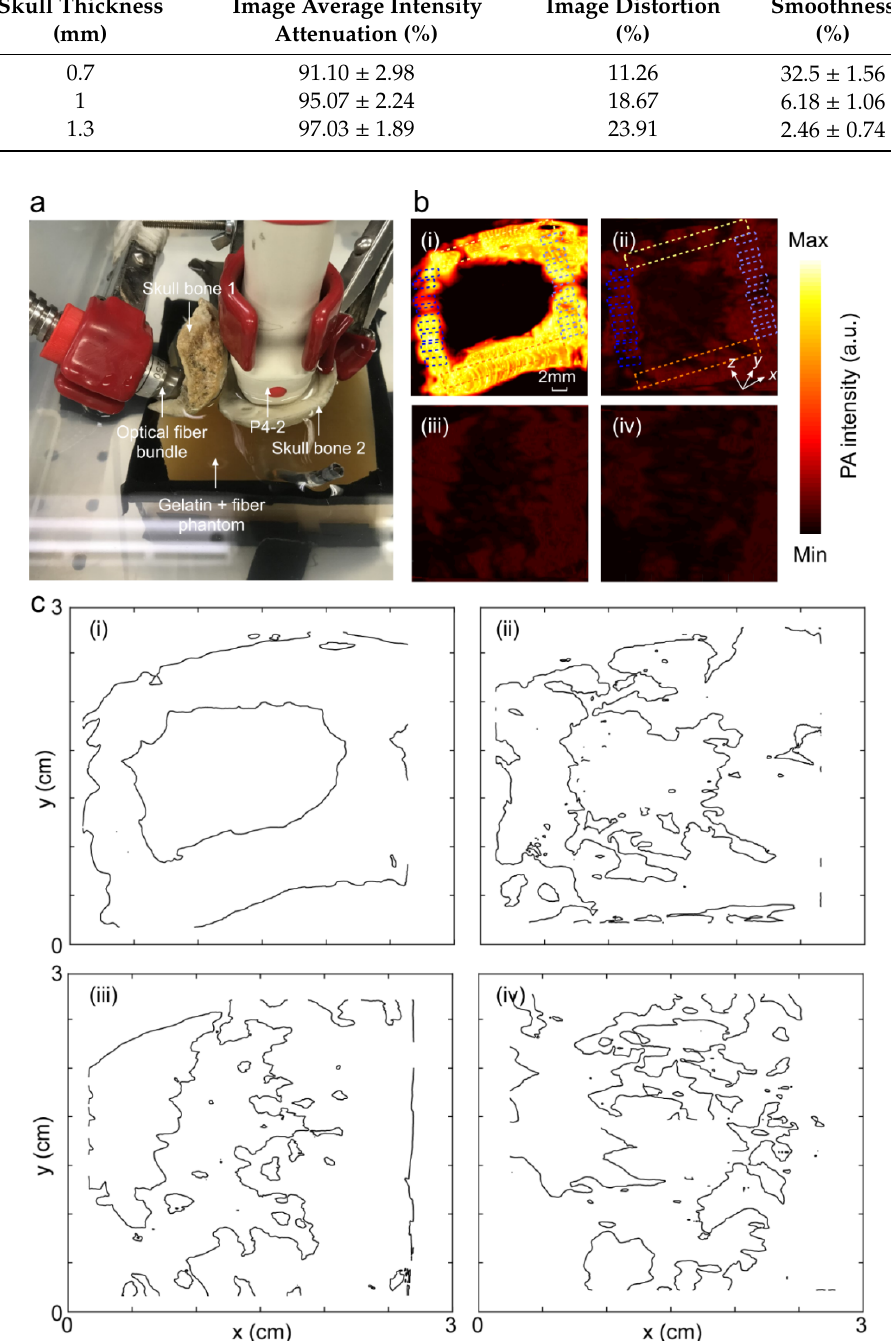
Figure 9. Image distortion analysis in photoacoustic imaging when the skull blocks both the light illumination and acoustic detection paths. ( a ) Experimental setup. ( b ) PA image of the square loop imaging target (i) without the skull, (ii) with a 0.7 mm skull, (iii) with a 1.0 mm skull, and (iv) with a 1.3 mm skull. ( c ) Contour map of the PA images representing the skull-induced deformation (i) without the skull, (ii) with a 0.7 mm skull, (iii) with a 1.0 mm skull, and (iv) with a 1.3 mm skull. The transducer was at a distance of 1.5 cm from the skull and the skull was at a distance of 3 cm from the square loop imaging target. Light green and orange ROIs are at the same depth from the transducer. This distance increases from the light to dark blue ROIs from 4.5 to 6 cm. Table 4. Summary of the quantitative evaluation of the PA imaging through the skull in gelatin with the fiber mixture when both the light illumination and acoustic propagation paths are blocked by the skull.